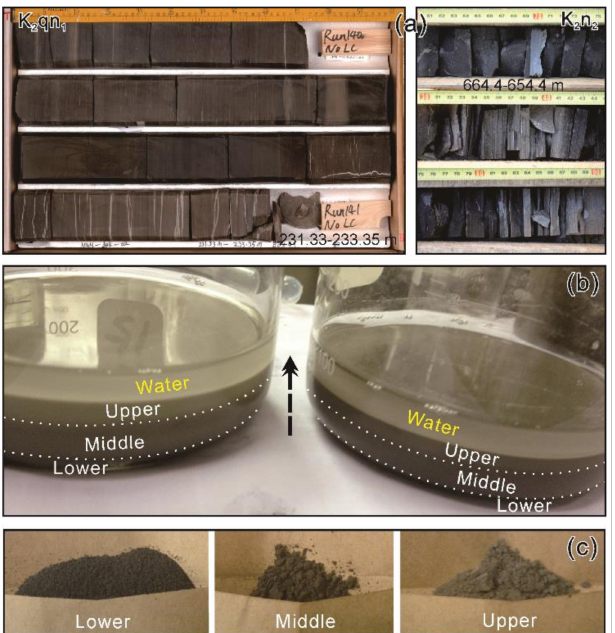
Figure 3. Settling layer-specified character for pulverized oil shales and mudstones from borehole Ngn2, exhibiting photographs of borehole cores ( a ), grain size separation in the water column for pulverized shales ( b ), and the powders of layer-specified particles ( c